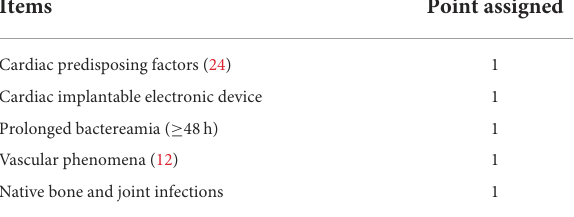
TABLE 2 Overview of LAUSTAPHEN score (cut-off ≥ 1